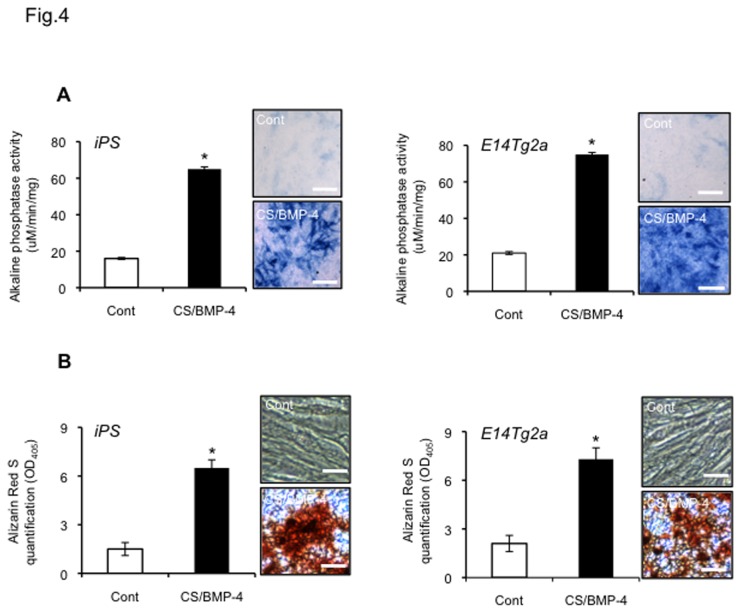
Expression of odontoblastic functional phenotypic markers.(A, B) Alkaline phosphatase (ALP) activity and calcification capacity are characteristic of differentiated odontoblasts, so were measured in iPS cells and E14Tg2a cells treated with or without CS/BMP-4. (A) ALP activity was measured by absorbance at 405 nm and normalized against total protein. (B) The mineralization of iPS and E14Tg2a cells was assessed by Alizarin Red-S (ARS) staining. ARS was measured as absorbance at 405 nm by an SH-1200 Lab instrument. Scale bars = 100 μm. (*P < 0.01, vs. control).